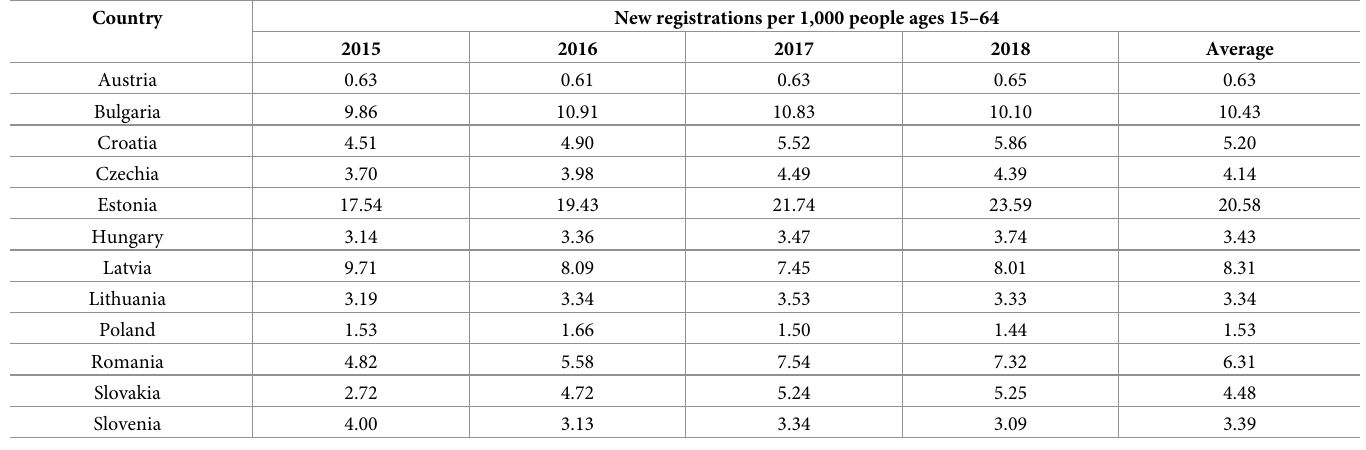
Table 6. New business density in 3SI countries.